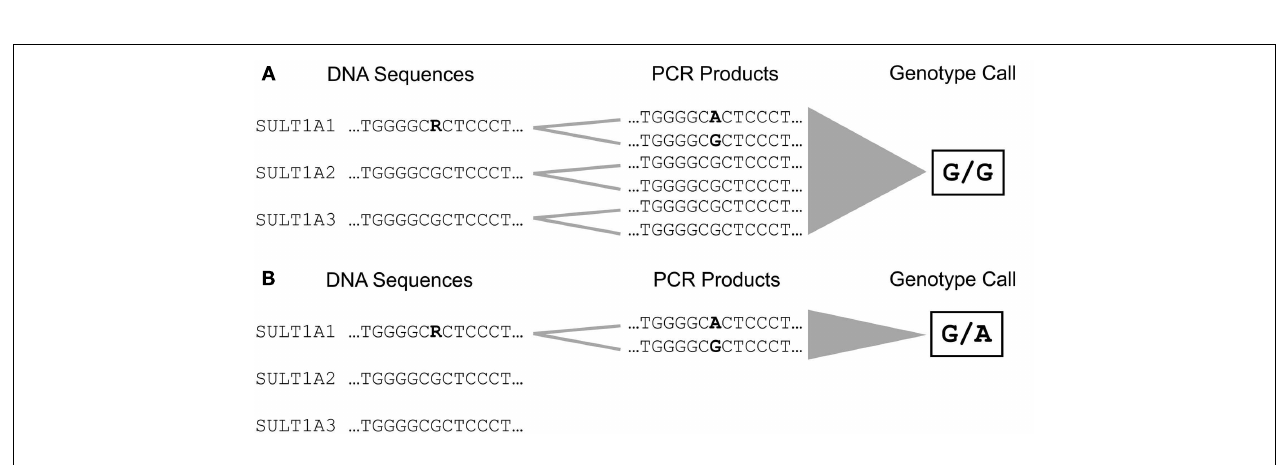
amplification products carrying the referent G allele leading to an incorrect genotype call for rs9282861 (homozygous GG). (B) Selection of primer binding sites specific for SULT1A1 enables amplification of the rs9282861 sequence region only resulting in correct determination of the genotype (heterozygous